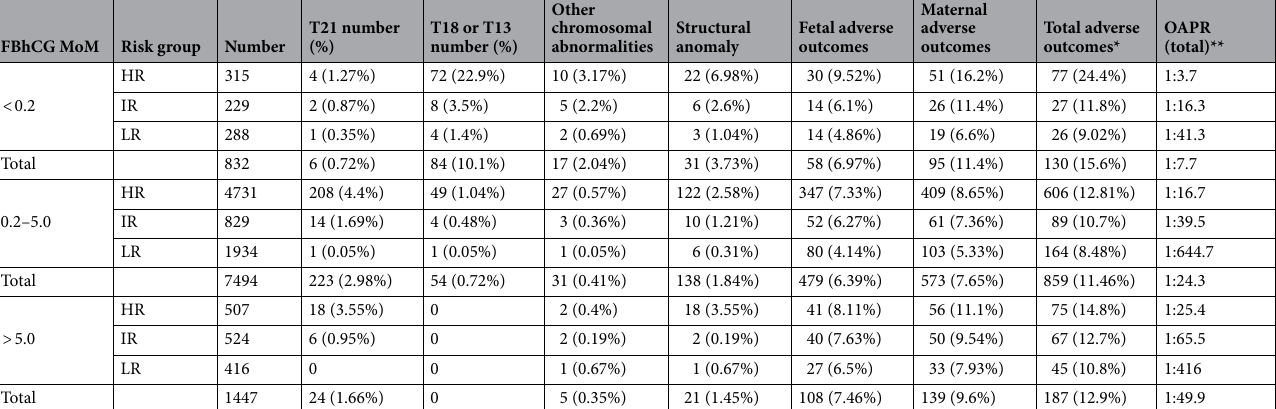
Table 4. Distribution of chromosomal abnormalities, structural anomalies, adverse fetal/maternal outcomes in different groups of pregnant women based on the levels of free βHCG MoM and calculated risk in first trimester screening (HR, high risk; IR, intermediate risk; LR, low risk). *Indicates the presence of at least one fetal/maternal adverse outcome. **Odds of being affected given a positive result.